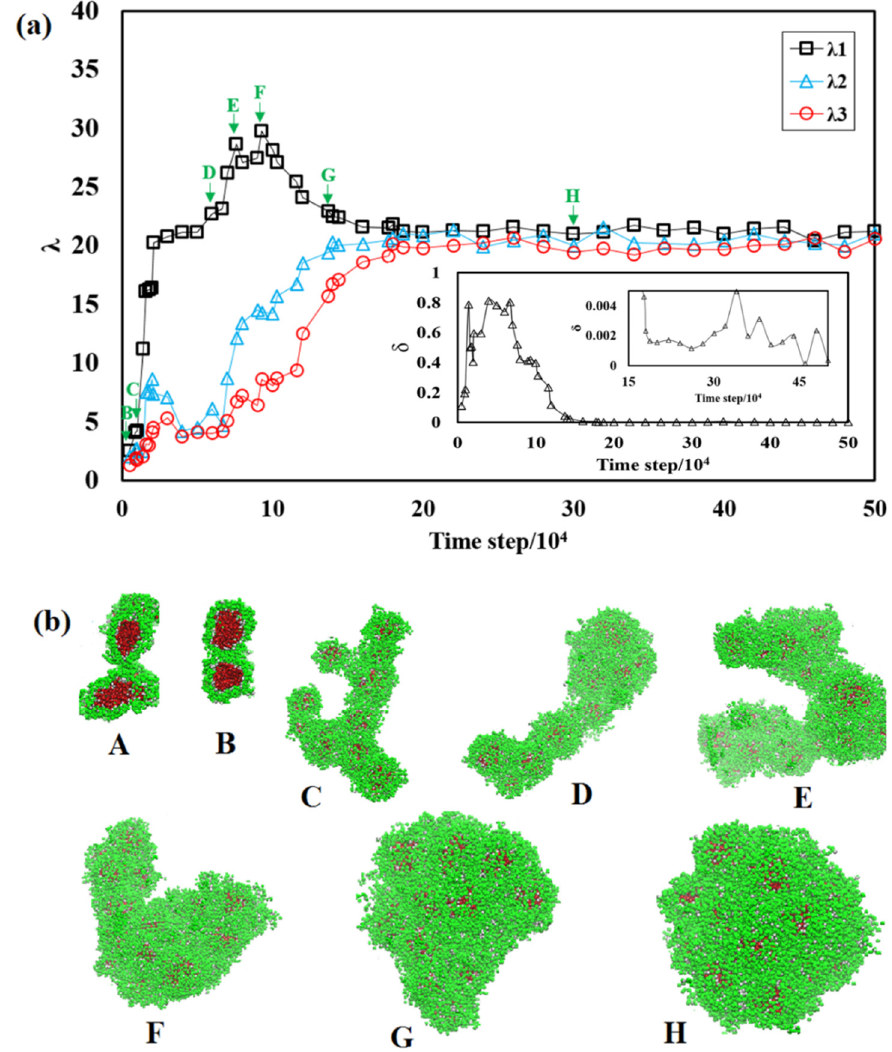
Figure 3. ( a ) The time evolution of λ l , λ 2 , and λ 3 of the largest aggregates at different simulation steps. The embedded figure is the corresponding asphericity, δ . ( b ) The corresponding morphologies of the largest aggregates. Solvent beads are omitted for clarity. The color codes are the same as those in Figure 1.